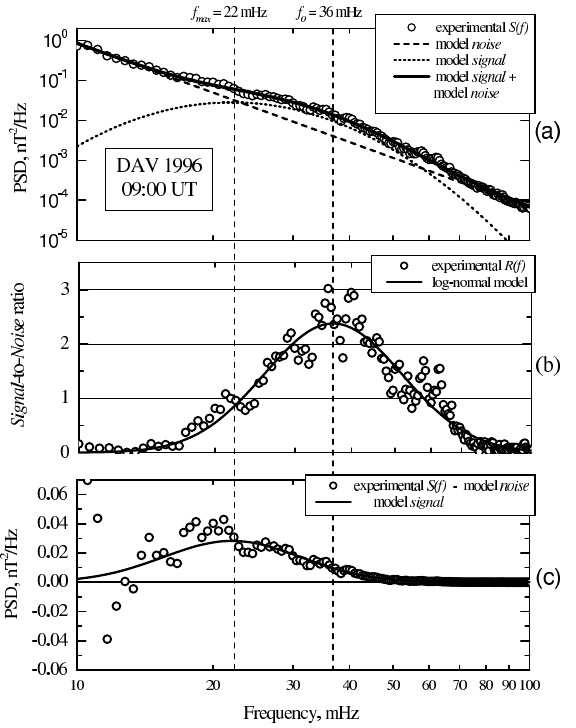
Fig. 4. Experimental (circles) and fitted model (solid line) spec- tra: (a) total power signal + noise , (b) signal -to- noise ratio, and (c) signal power obtained for the power spectrum for 09:00UT in Fig. 2. Dashed and dotted lines in (a) show model noise and signal power, respectively. f 0 indicates the frequency where the observed signal -to- noise ratio reaches a spectral maximum; f max is the fre- quency where the signal has maximum PSD.